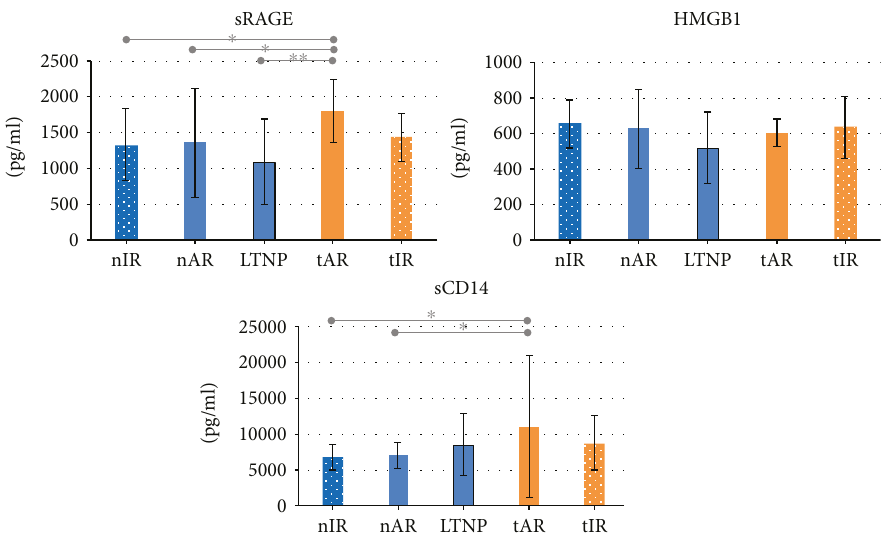
Figure 2: Plasma levels of soluble receptor for advanced glycation end products (sRAGE), high-mobility group-box 1 protein (HMGB1), and soluble CD14 (sCD14) proteins of the 92 people living with HIV/AIDS, according to the fi ve studied groups. It is noted that sRAGE and sCD14 were higher in tAR than in naïve groups. Statistical tests: Tukey-Kramer for sRAGE and gamma distribution for the others. ∗ p < 0 05 ; ∗∗ p < 0 005 .